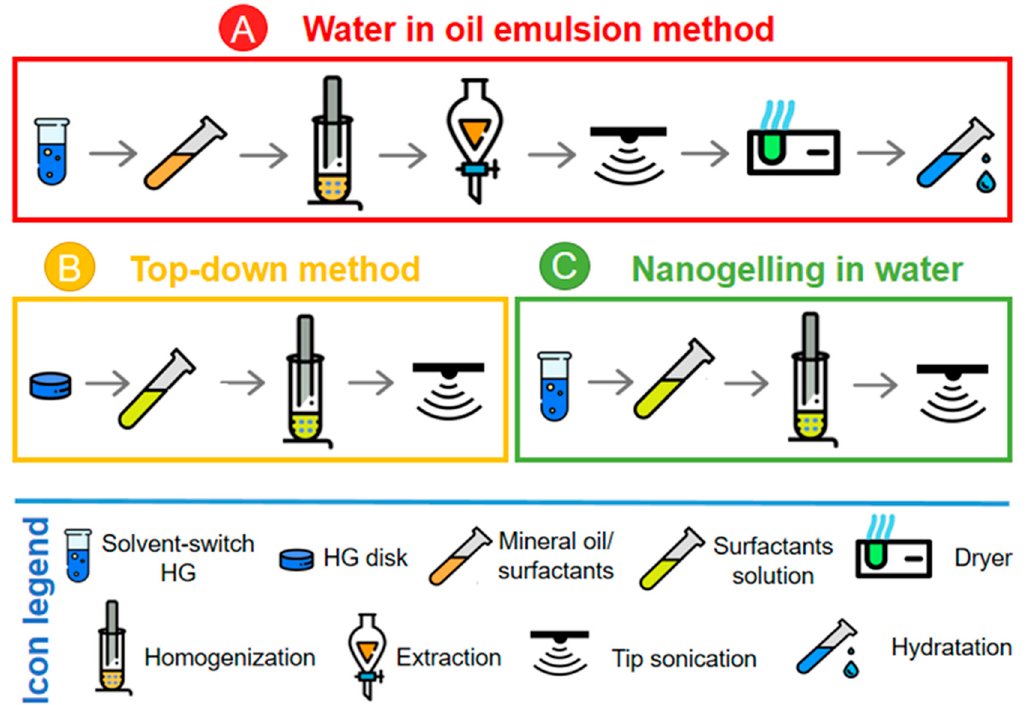
Figure 1. Icons graphical representation of the three different strategies for the nanogel formulation. ( A ) Water-in-oil emulsion methodology; ( B ) Top-down method; and ( C ) Nanogelling in water approach. Each step is identified using an icon of which the legend is reported too.